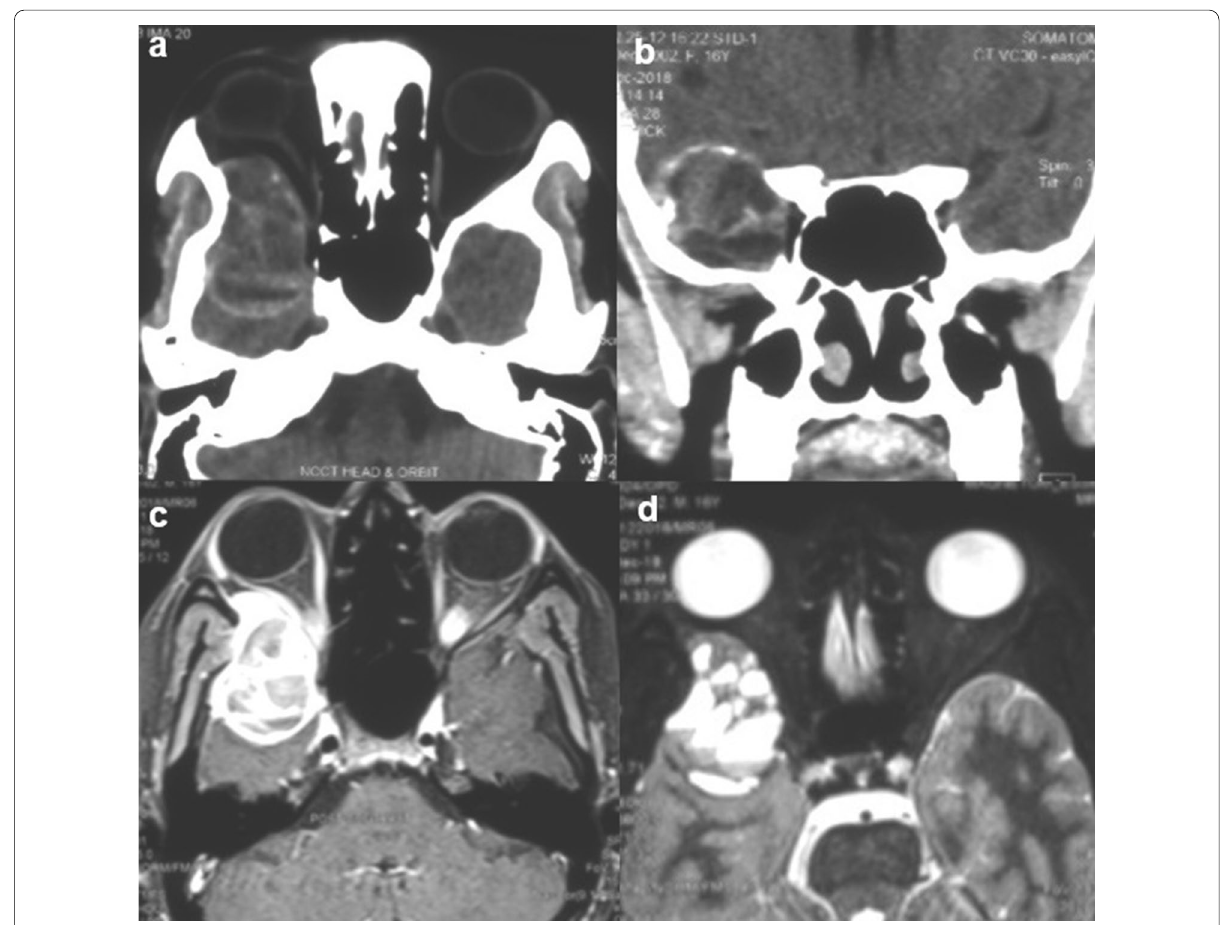
Fig. 1 The axial ( a ) and coronal ( b ) views of preoperative NCCT head showing a heterogenous lesion, extending anteriorly into the orbit and causing proptosis. Preoperative axial CEMRI ( c ) and T2 sequence ( d ) showing an expansile lytic lesion arising from the greater wing of sphenoid wing with multiple locules within, showing blood fluid level and enhancement of wall and